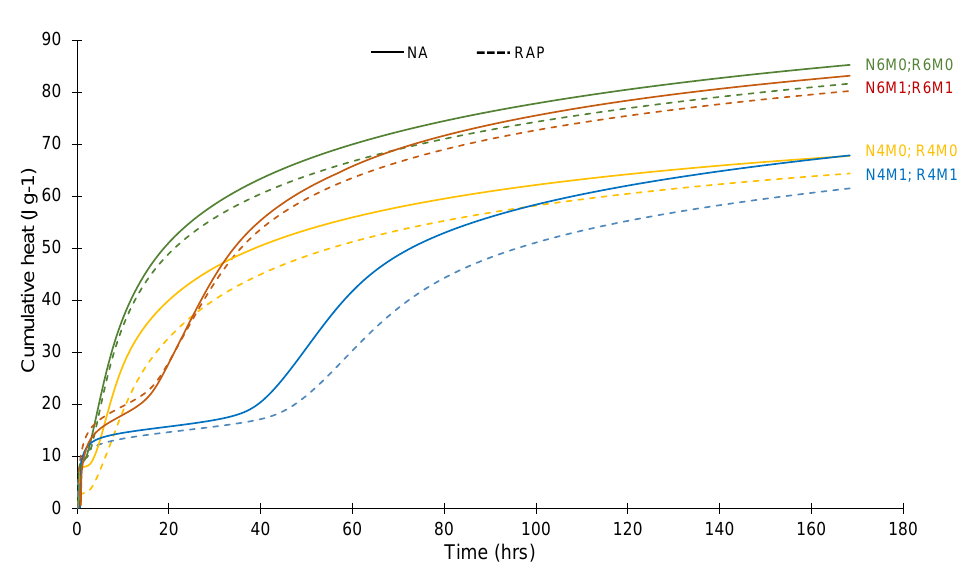
Figure 7. Cumulative heat of alkali-activated samples.